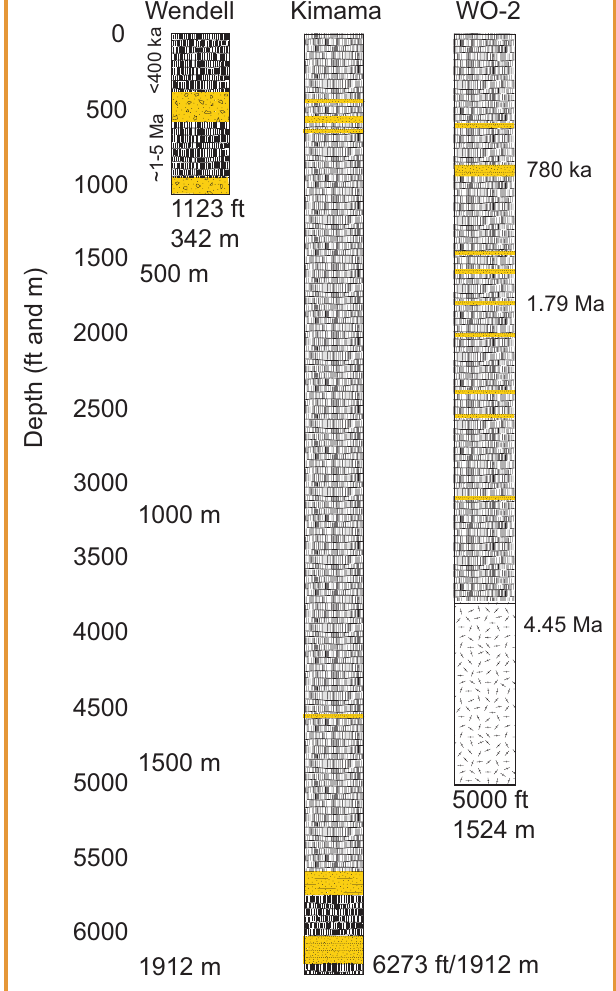
Figure 2. Lithologic log of the Kimama well compared to the Wendell-RASA well and WO-2 well at Idaho National Laboratory. See Fig. 1 for locations. Yellow stipple: sediment; white stipple: rhyolite; dark pattern: